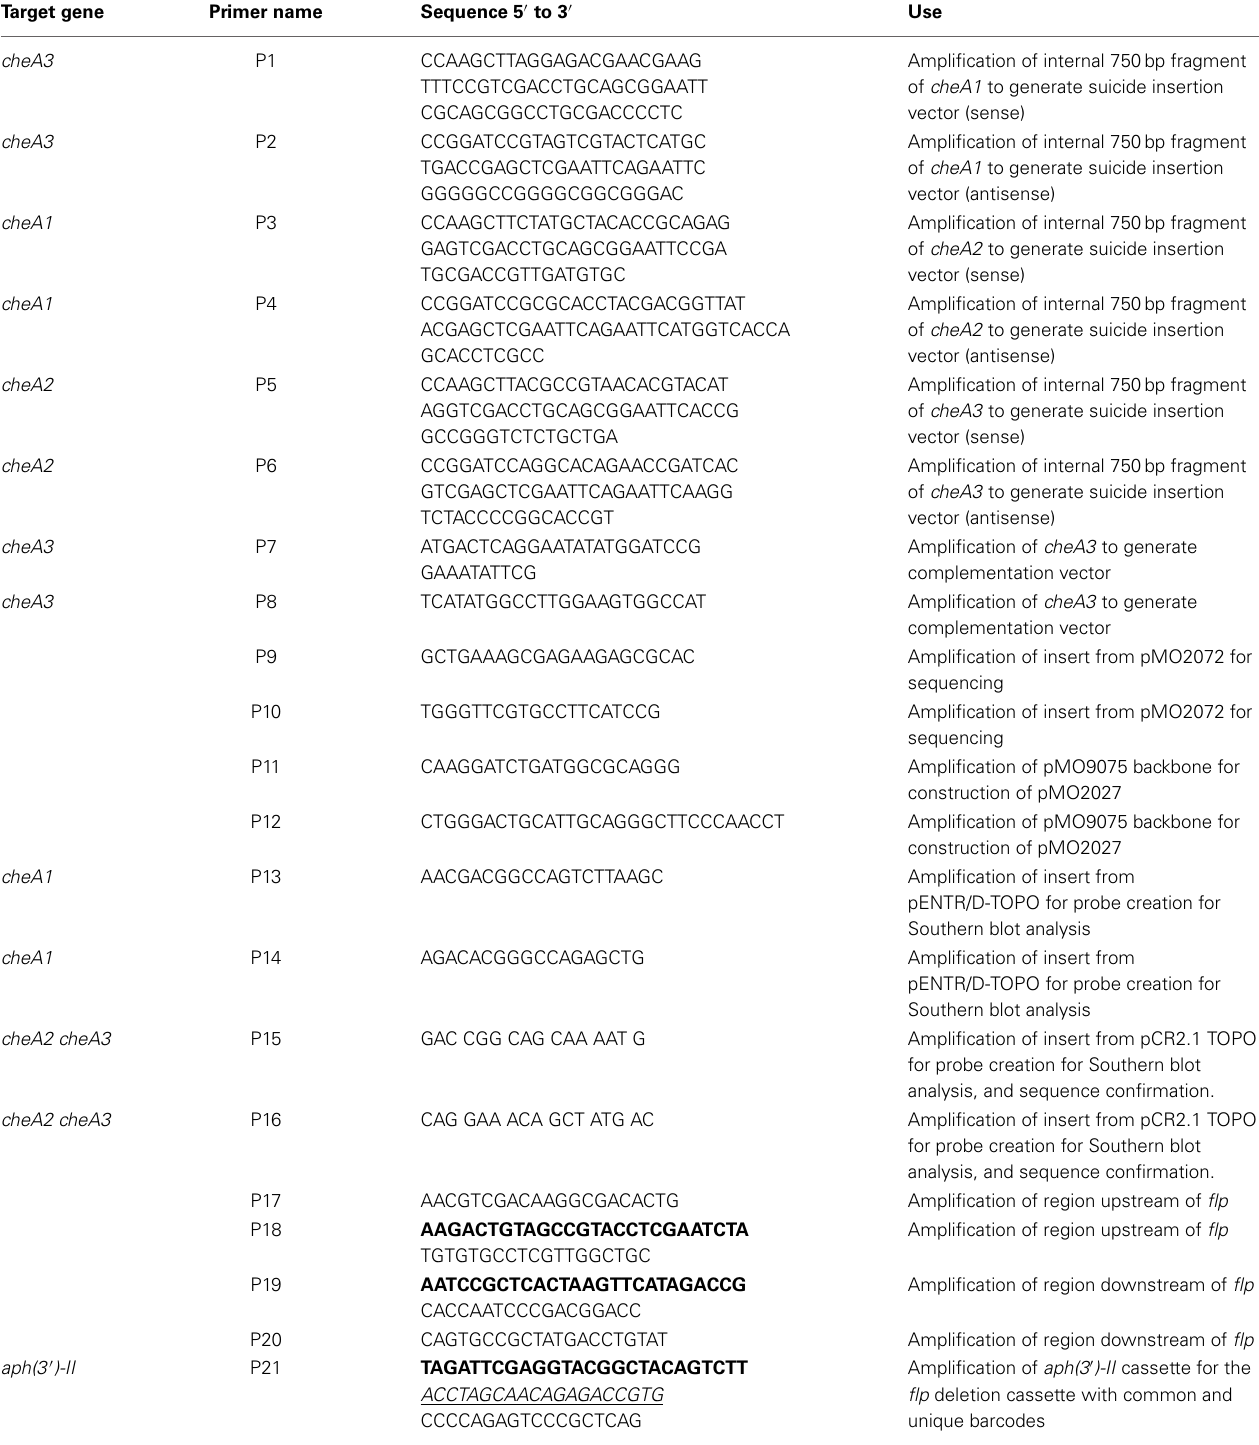
Table A1 | Primers used for Southerns and Sequencing